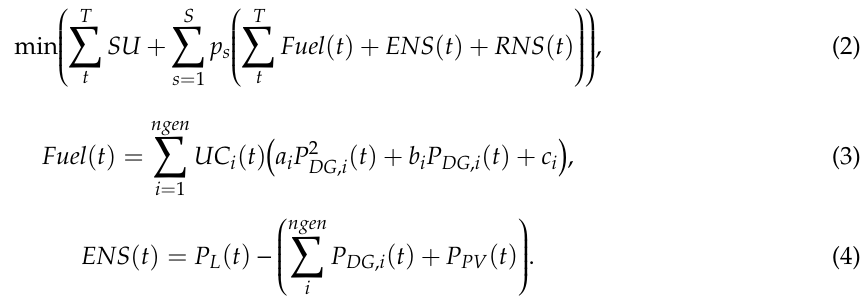
scenarios and ( d ) load profile scenarios. 168